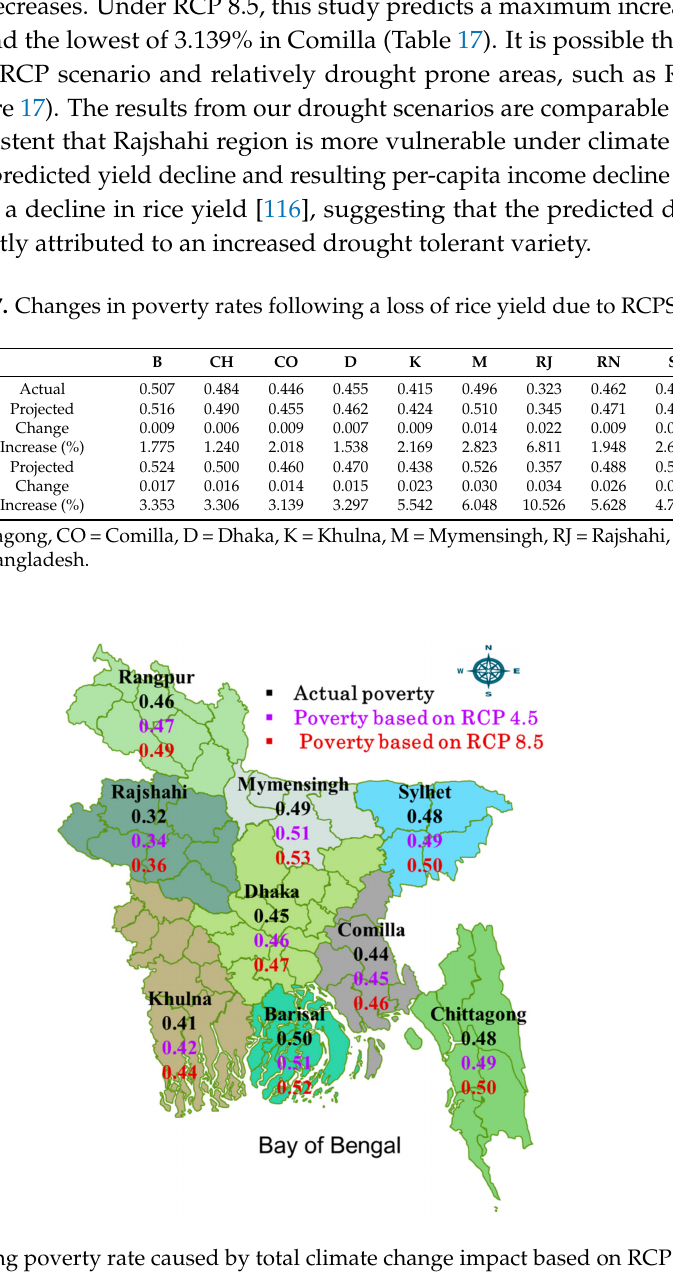
Figure 17. Changing poverty rate caused by total climate change impact based on RCP 4.5 and